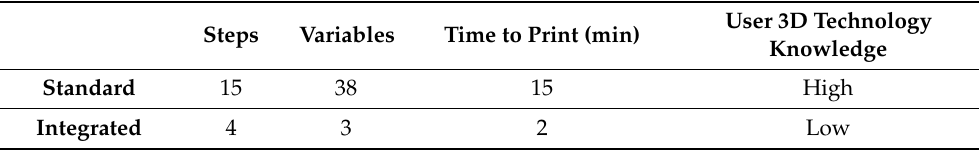
Table 6. Experimental evaluation of standard and integrated 3D printing environments with non- standard